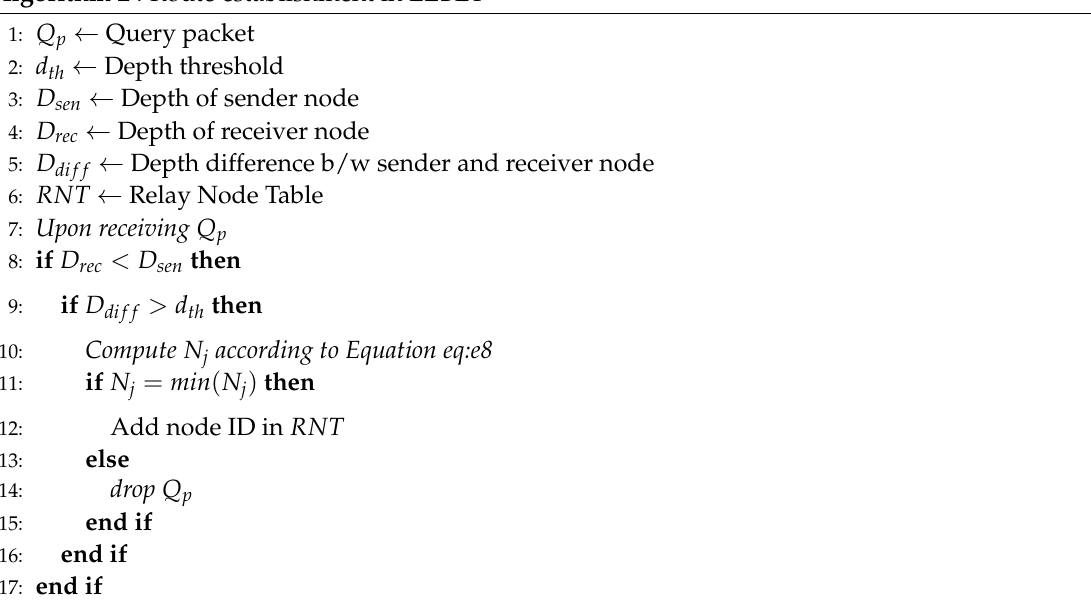
Algorithm 2 : Route establishment in